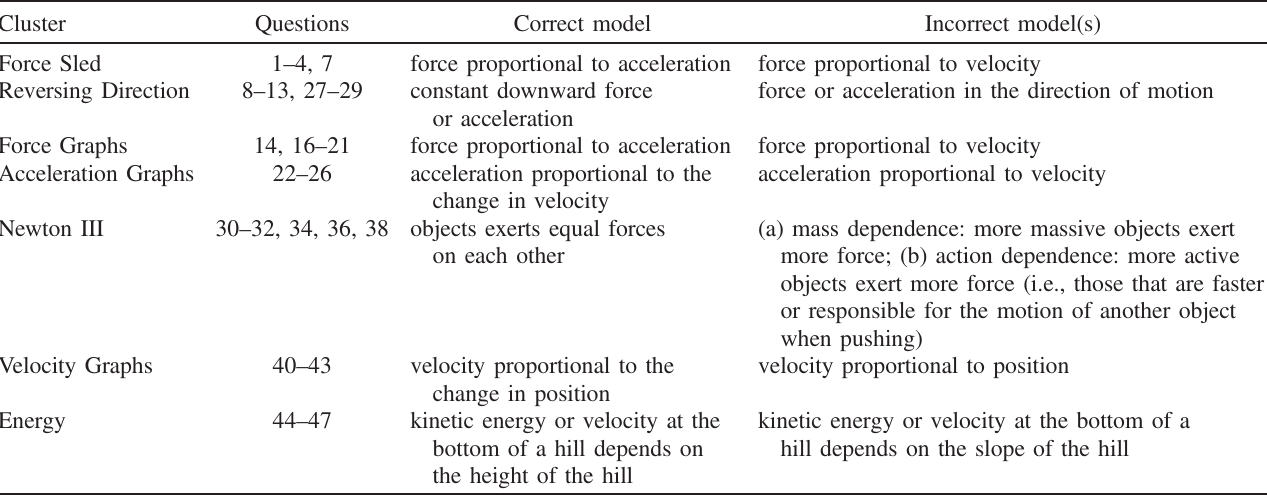
TABLE I. Revised questions clusters on the FMCE with corresponding correct and common incorrect models. See Ref. [4] for full